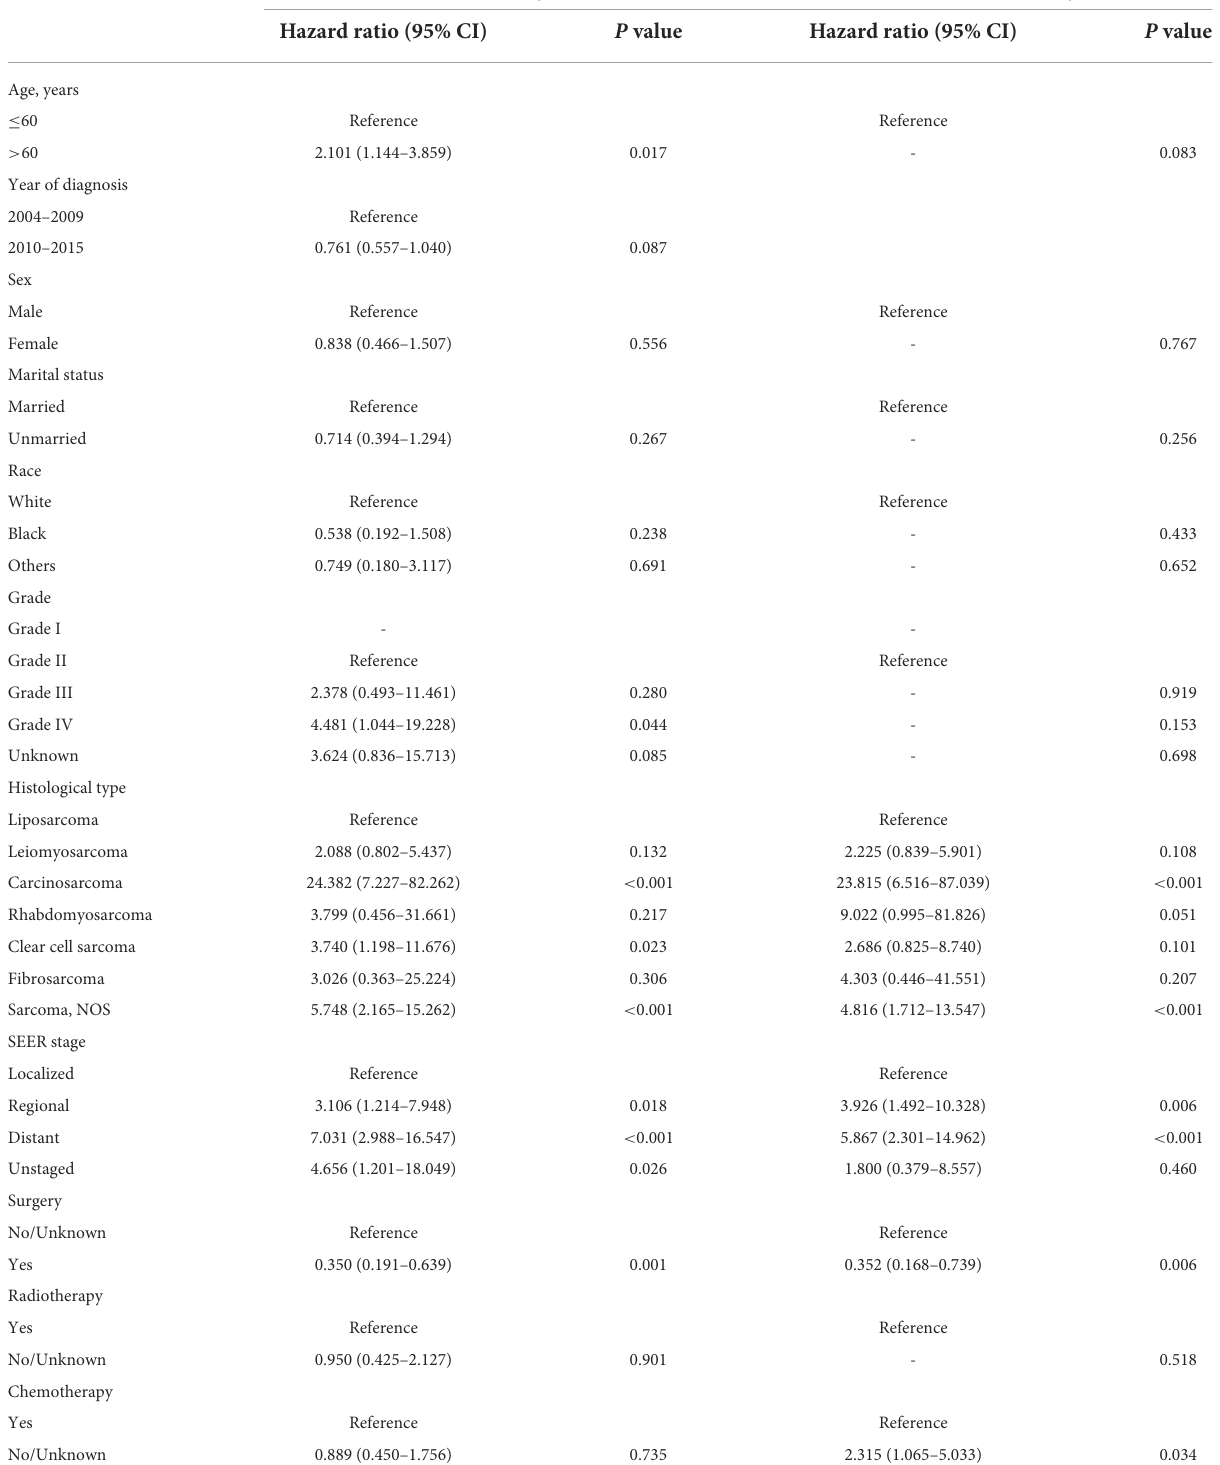
TABLE 3 Univariate and multivariate analysis of cancer-specific survival (CSS) rates in the training cohort.